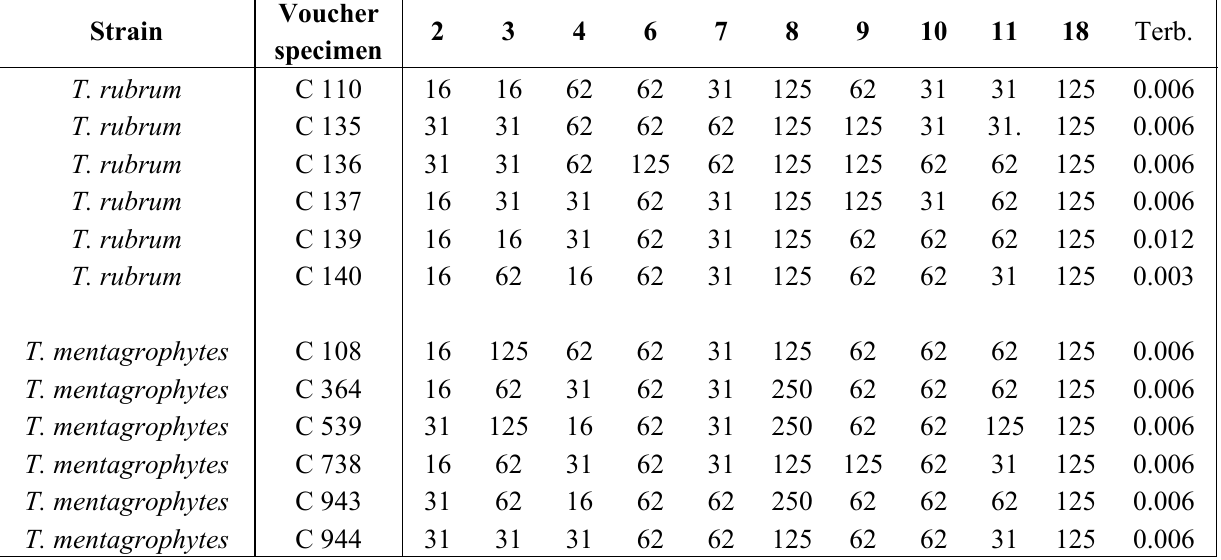
Table 4. Minimum Inhibitory Concentration (MIC clinical isolates of Trichophyton